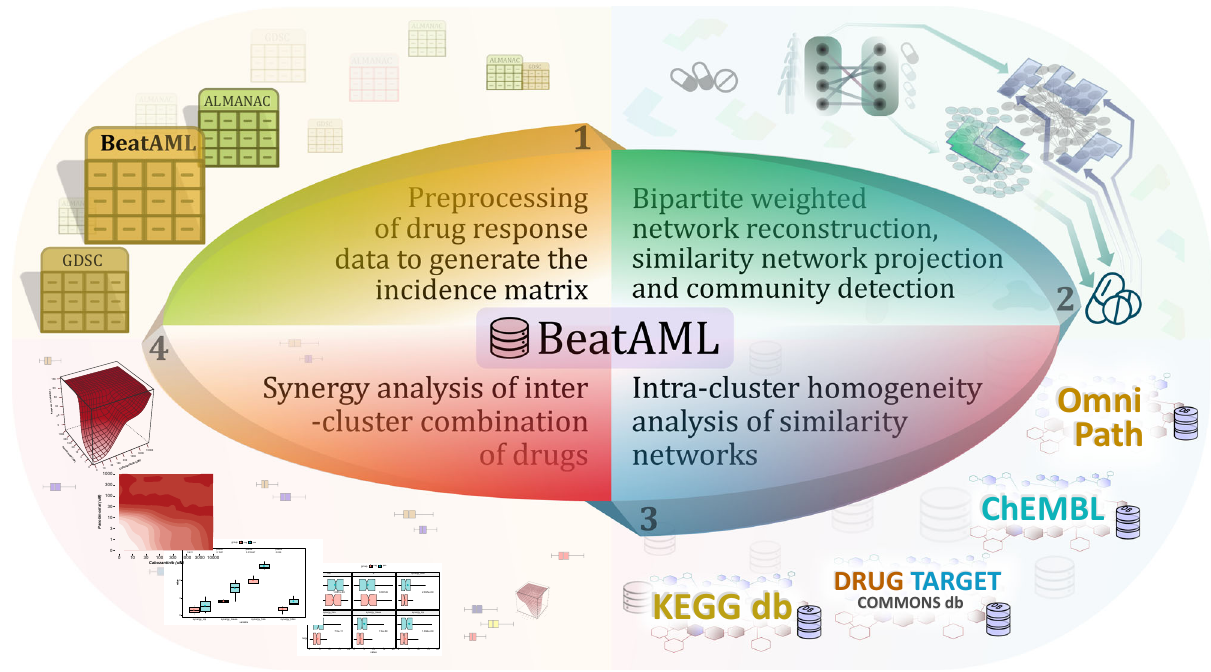
Fig. 1 Flowchart of the study. Data collection and pre-processing began with the Beat AML drug response dataset, which was then followed by incidence matrix extraction, weighted bipartite network reconstruction, network projection, and community detection. The intra-cluster homogeneity analysis was carried out using the similarity of drug and patient/cell members of all clusters according to available gene expression pro fi les, drug – target interactions, protein – protein interactions, and biological pathways using the ChEMBL, Omnipath, DrugTargetCommons, and KEGG databases. A high-throughput drug screening experiment was then used to investigate the synergistic behaviour of each drug combination that had been suggested. Furthermore, additional drug response datasets, GDSC and ALMANAC, were used for the intra-cluster homogeneity analysis and inter-cluster drug combination strategy steps, respectively, in order to examine whether the proposed work fl ow is dataset